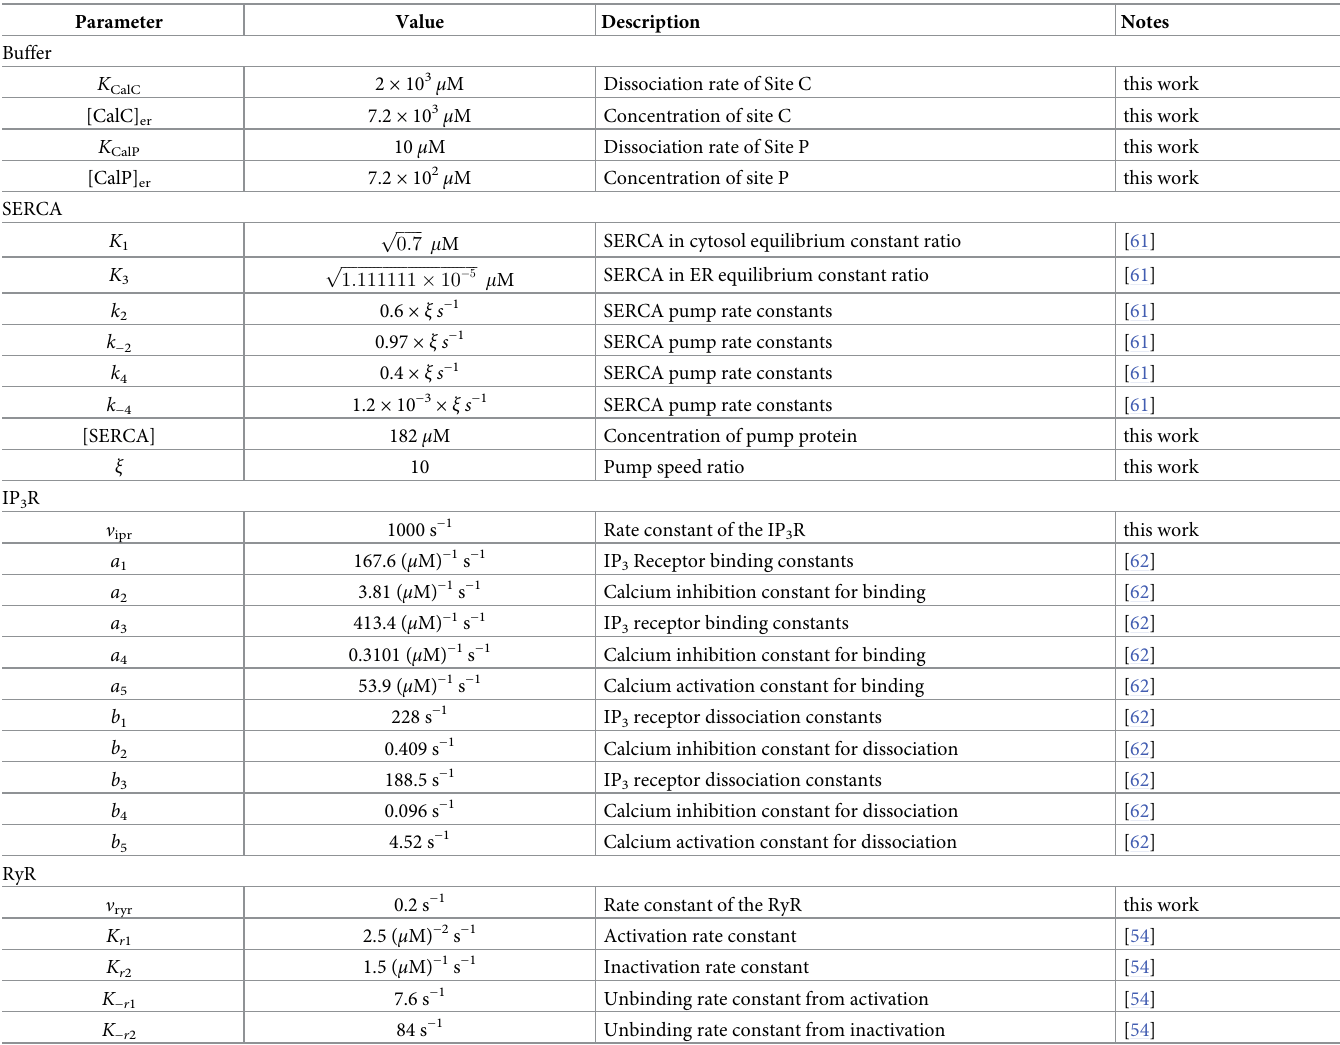
Table 3. ER model